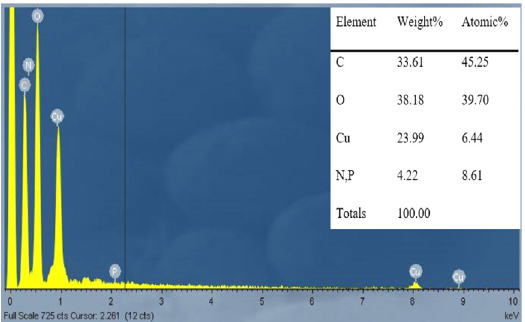
Fig. 5. Energy dispersive X-ray (EDX) spectra of Cu O NCBs/CS NPs 2